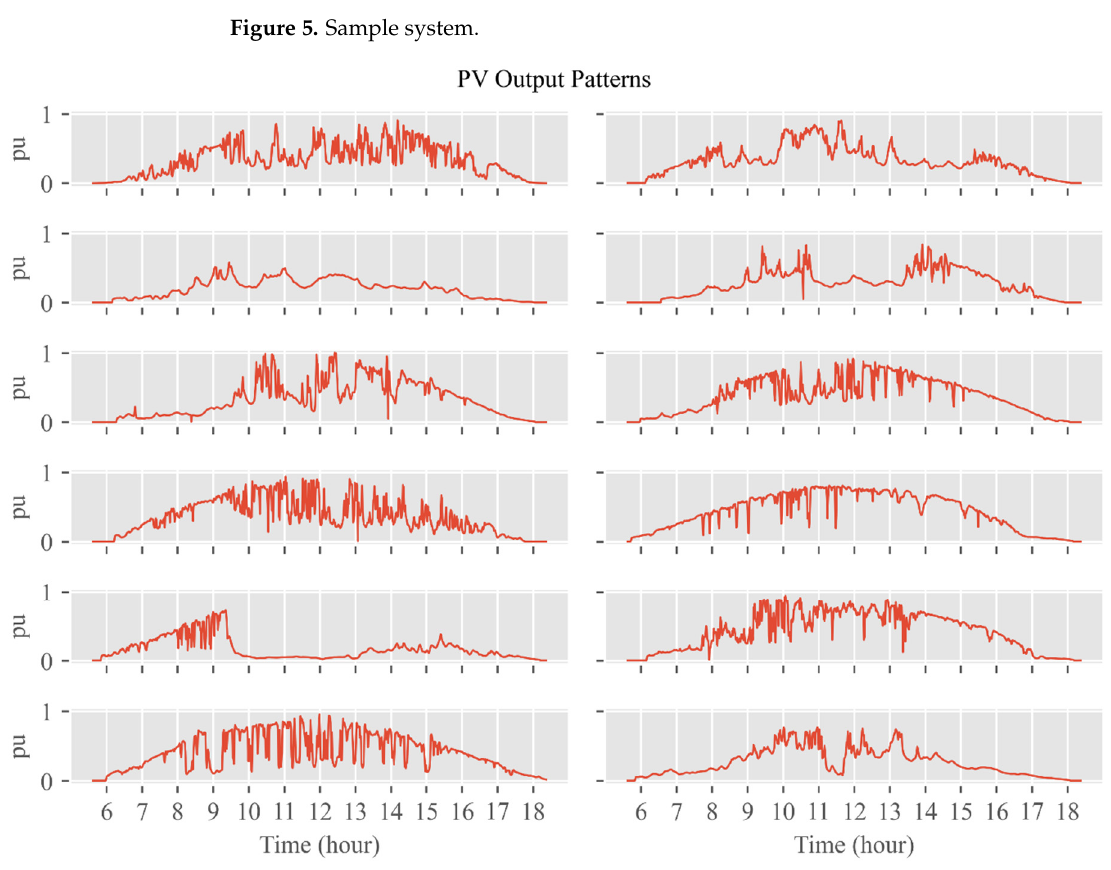
Figure 6. PV output patterns.